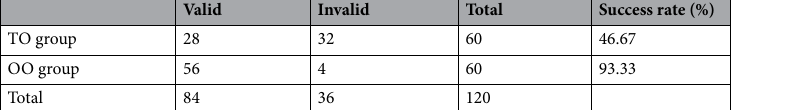
Valid Invalid Total Success rate (%) TO